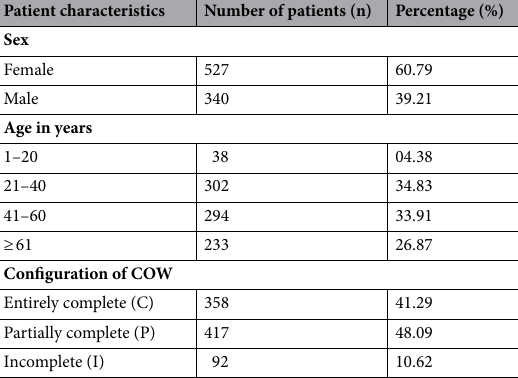
Table 1. Demographic and COW * configuration characteristics of patients. *Circle of Willis.